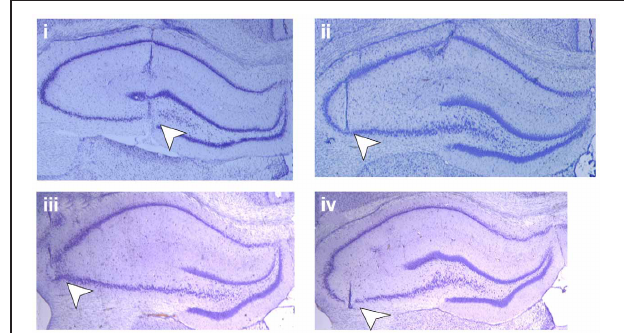
FIGURE 1 | Position of the electrodes. Photomicrographs of Nissl-stained hippocampal slices show placement of electrodes (white arrowheads) in mf-CA3 and AC–CA3 preparations: (i) shows the position of the stimulation electrode in the mossy fiber pathway and (ii) the position of the recording electrode in area CA3 stratum lucidum, whereas picture (iii) shows the stimulating electrode in the associational-commissural pathway and (iv) the recording electrode in area CA3 stratum